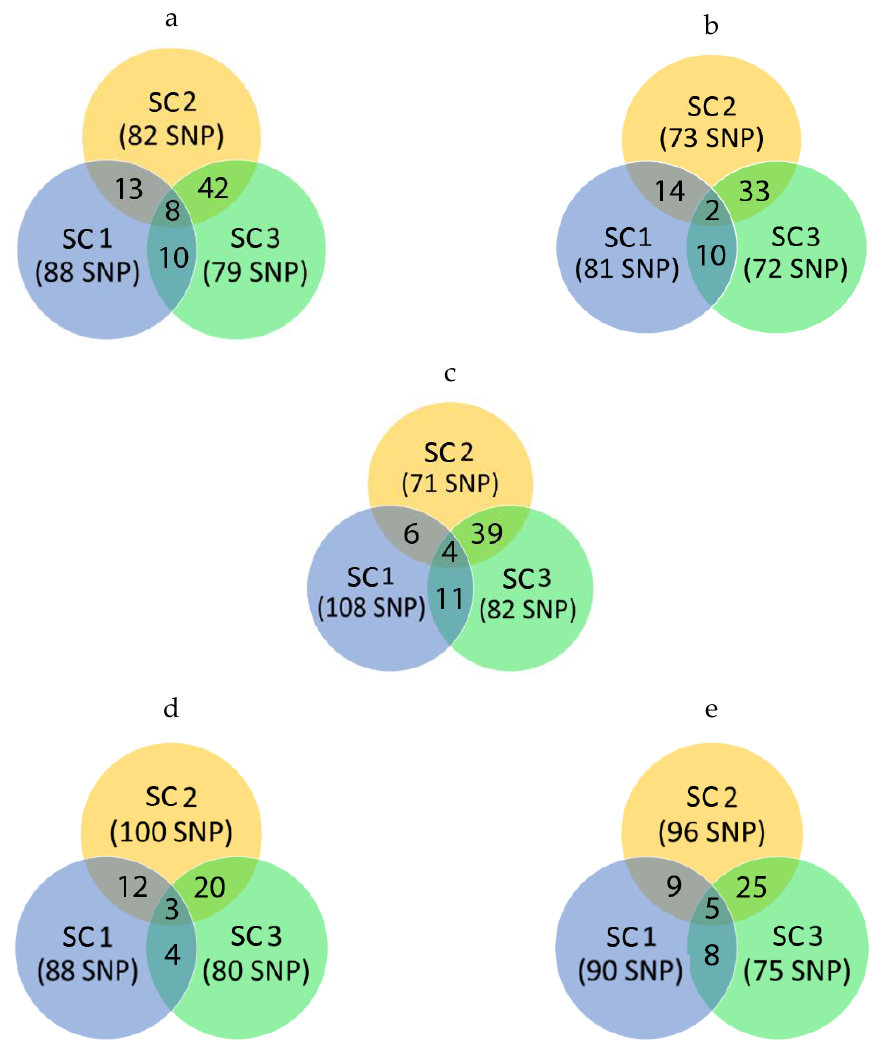
Figure 2. Trait/Venn diagrams showing common SNP in different groups. Values in brackets indicate the total number of SNP markers which explain 5% of a trait variability based on the respective reference group. Set intersections indicate the number of SNP markers that explain 5% of the trait variability common for calculations based on Scenarios 1 – 3 (SC1 — Scenario 1, SC2 — Scenario 2, SC — Scenario 3); a — for backfat thickness over 6 – 7 ribs (BF1), b — for muscle depth (MD), c — for days to 100 kg (Age), d — for number of all piglets born at the first farrowing (TNB), e — for number of piglets born alive at the first farrowing (NBA)